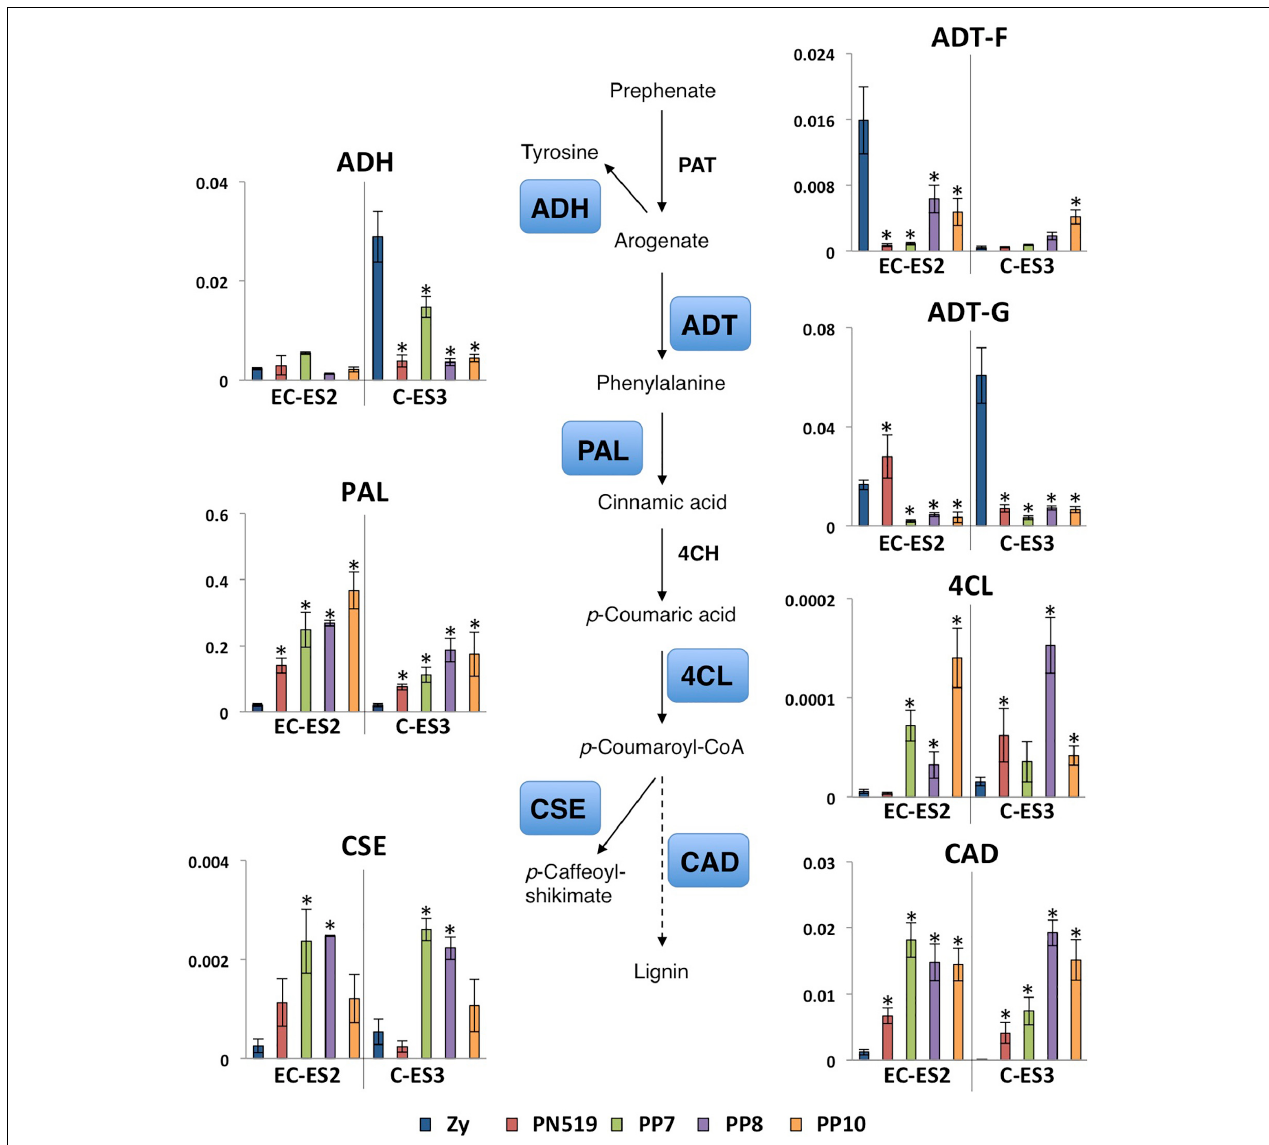
FIGURE 8 | Differential expression of genes involved in phenylalanine biosynthesis and utilization. Quantitative analysis of transcript levels for genes that are differentially expressed in zygotic embryos (Zy) at early cotyledonary (EC) and cotyledonary stages (C) versus four somatic lines, PN519, PP7, PP8, and PP10, at pre-cotyledonary opaque (ES2) and cotyledonary (ES3) stages. Genes included in the analysis were those encoding arogenate dehydratase (ADT-F and ADT-G isoforms) ADH, arogenate dehydrogenase; PAL, phenylalanine ammonia-lyase; 4CL, 4-coumaroyl-CoA ligase; CSE, caffeoyl shikimate esterase; and CAD, cinnamyl alcohol dehydrogenase. Each value is the mean ± standard deviation of three biological replicates. Asterisks indicate significant differences between zygotic and somatic samples calculated using Student’s t -test ( P < 0.01). The expression level for all genes was normalized to that of Actin-7 as a reference